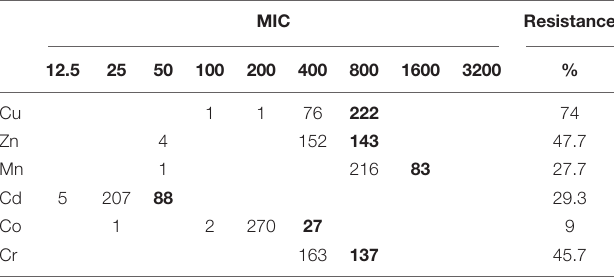
TABLE 1 | Incidence of metal resistance among 300 Salmonella Typhimurium strains isolated from pig meat, pig manure, poultry manure, chicken meat, and human stool samples.